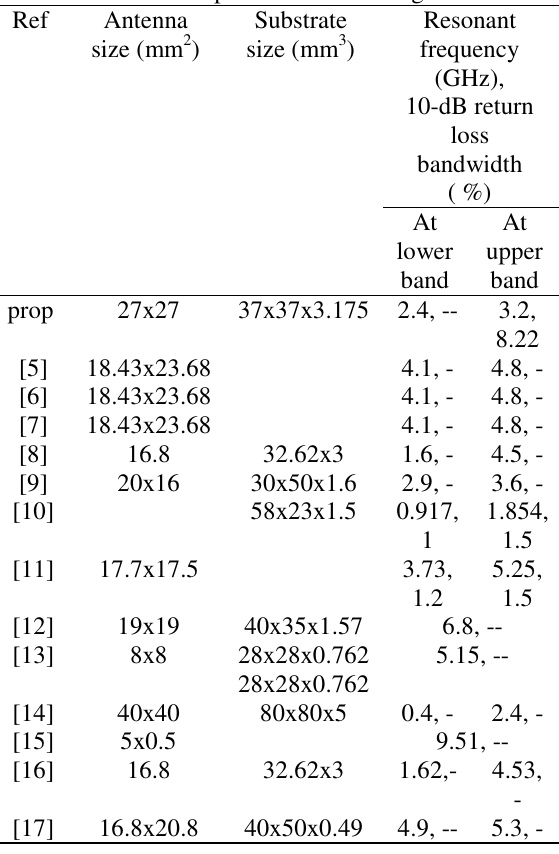
Table 3: Comparison with existing